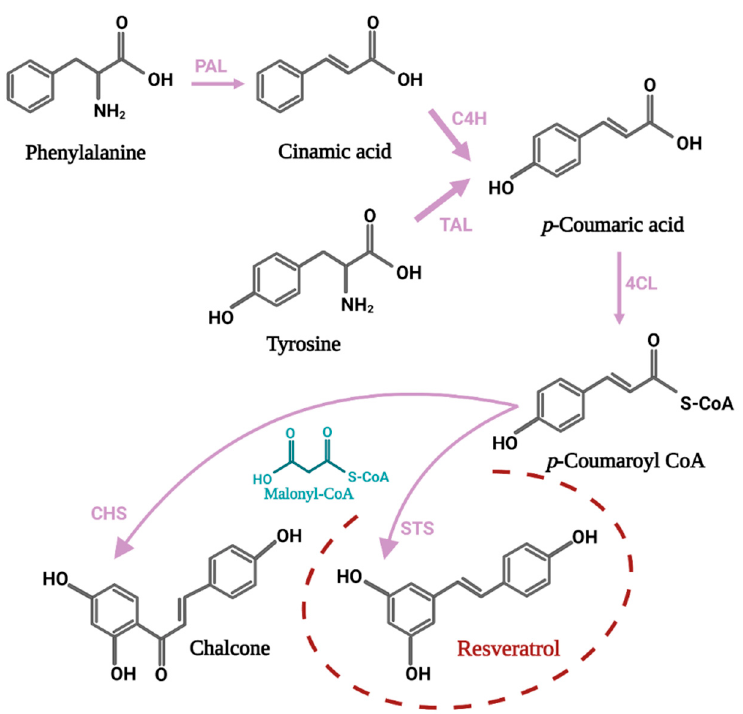
Figure 2. The connection between the resveratrol biosynthesis pathway and the biochemical pathway for synthesis of flavonoids, represented by the first intermediate called chalcone. The enzymes involved in the chemical reactions have been abbreviated as follows: PAL—Phenylalanine ammonia lyase; C4H—Cinnamate-4-hydroxylase; TAL—Tyrosine ammonia-lyase; 4CL—Coumaroyl-CoA ligase; STS—Stilbene synthase; CHS—Chalcone synthase.